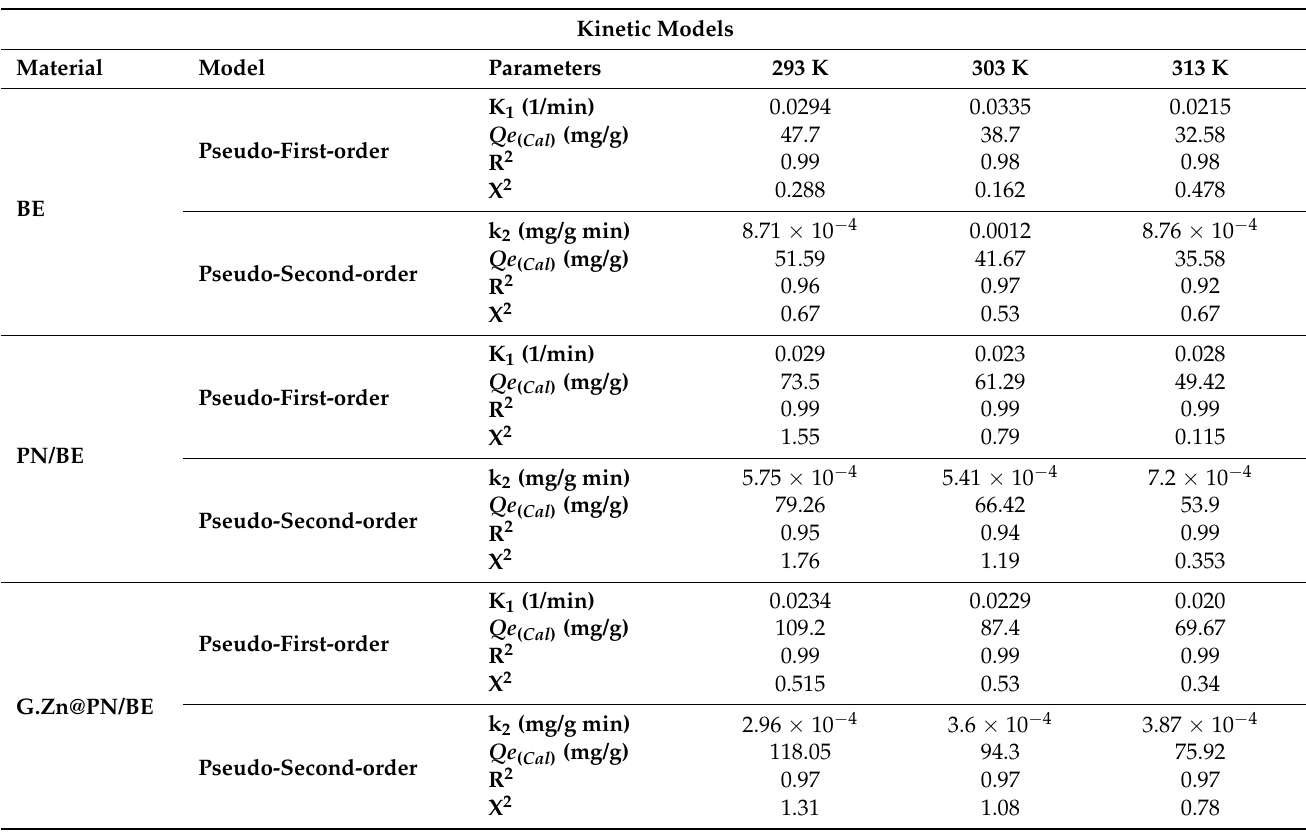
Table 1. The mathematical parameters of the addressed kinetic and classic isotherm models. Kinetic